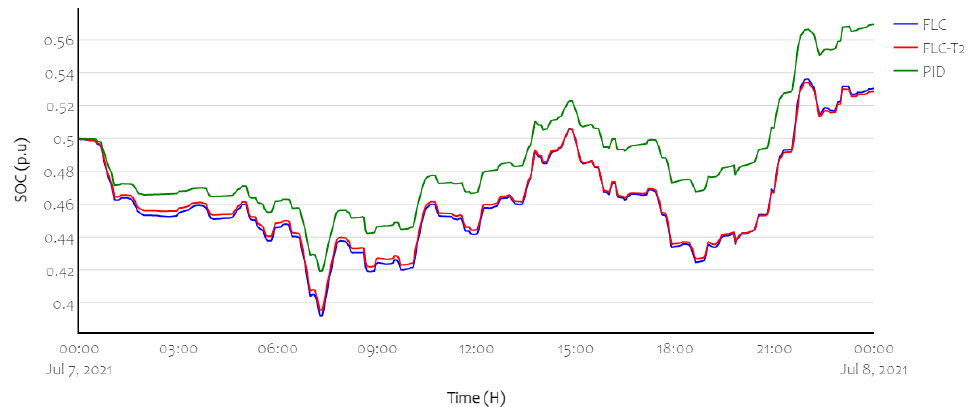
Figure 4. Comparison of BESS state-of-charge with the EFR controller on a working day managed by conventional FLC ( blue ), PID controller ( green ), and Type-2 FLC ( red ).